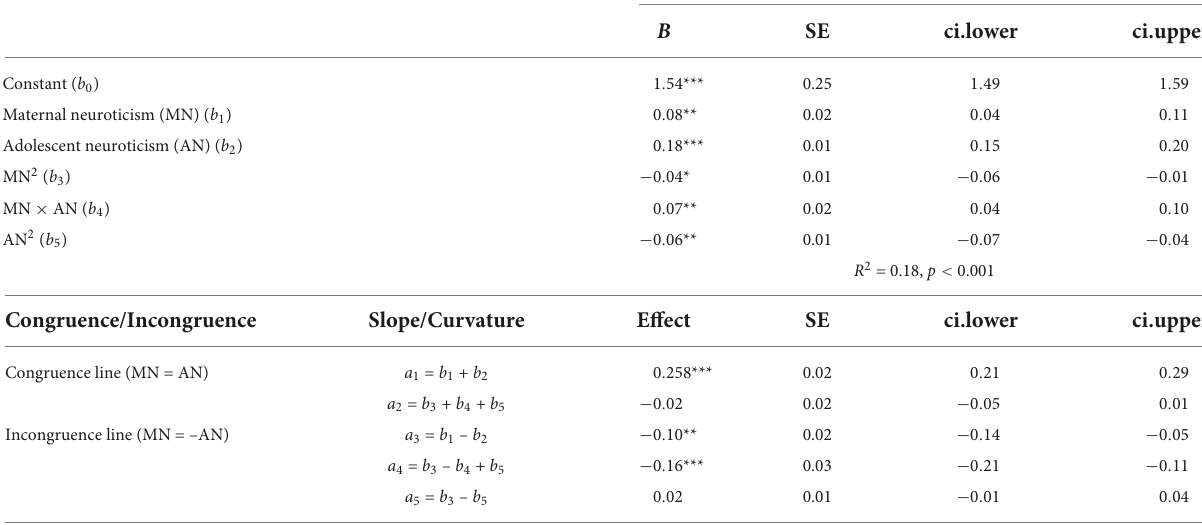
TABLE 2 Polynomial regressions of punitive parenting style on neuroticism congruence/incongruence.